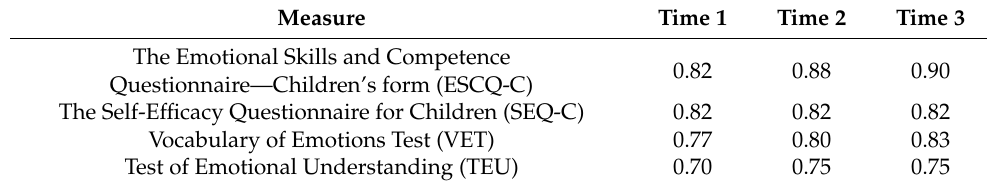
Table 2. Cronbach Alpha reliability coefficients for used measures in three measurement